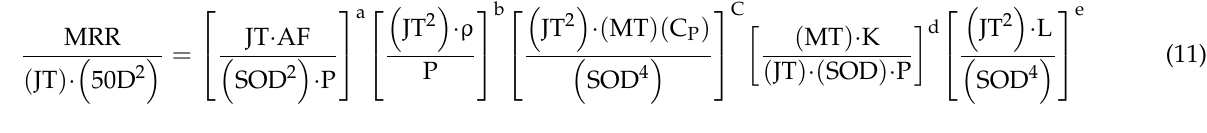
Table 3. The characteristics of the MRR performance are represented by the π term. π Term Expression. The Final Value of π